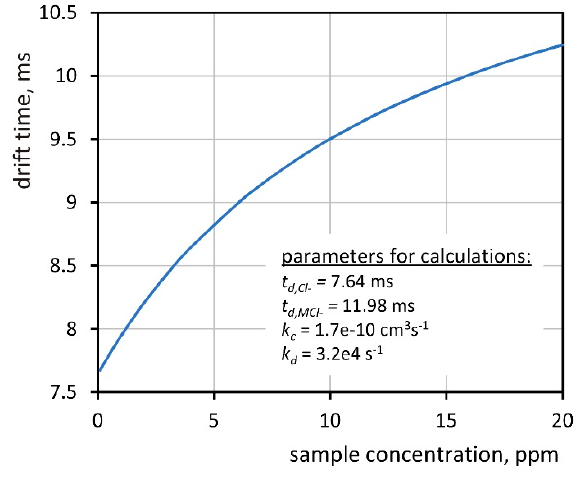
Figure 3. The dependence of the effective drift time on the sample concentration.